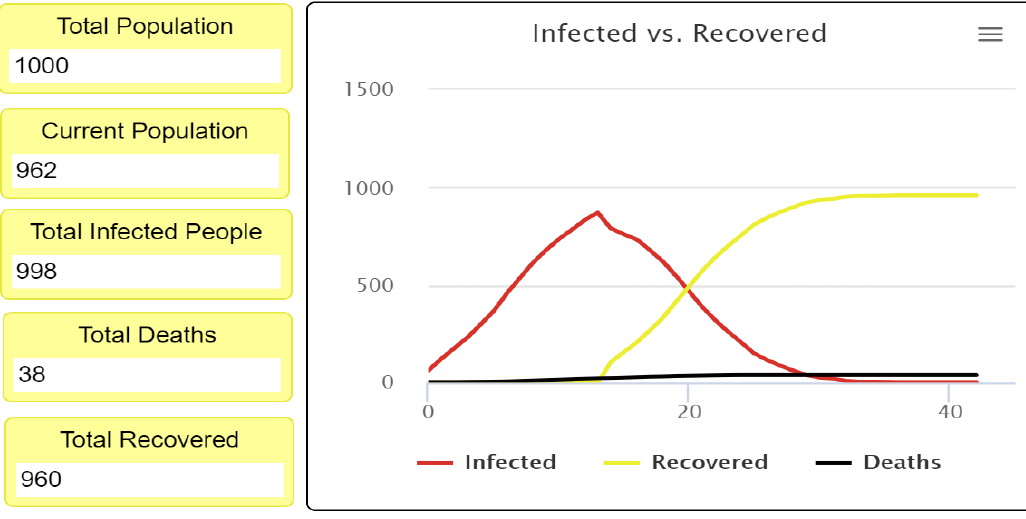
Figure 12. Movement patterns in the second experiment with 30% social distancing. The final visualization of movement patterns in the second experiment (Figure 12) indicates that the infected and recovered agents’ movement patterns are lower than those in the first experiment. In contrast, the healthy agents’ movement patterns are more sig- nificant in the second experiment, meaning that a significant reduction of infection and an improvement of survival rate was achieved. Based on Figure 13, using a 30% rate of social distancing reduces the number of in- fected people and deaths compared to the previous experiment. While the number of in- fected people was 995 in the first experiment, the number dropped to 701 infected cases in the second experiment. Therefore, the decline in infected numbers of people in the sec- ond experiment led to a decrease in deaths.